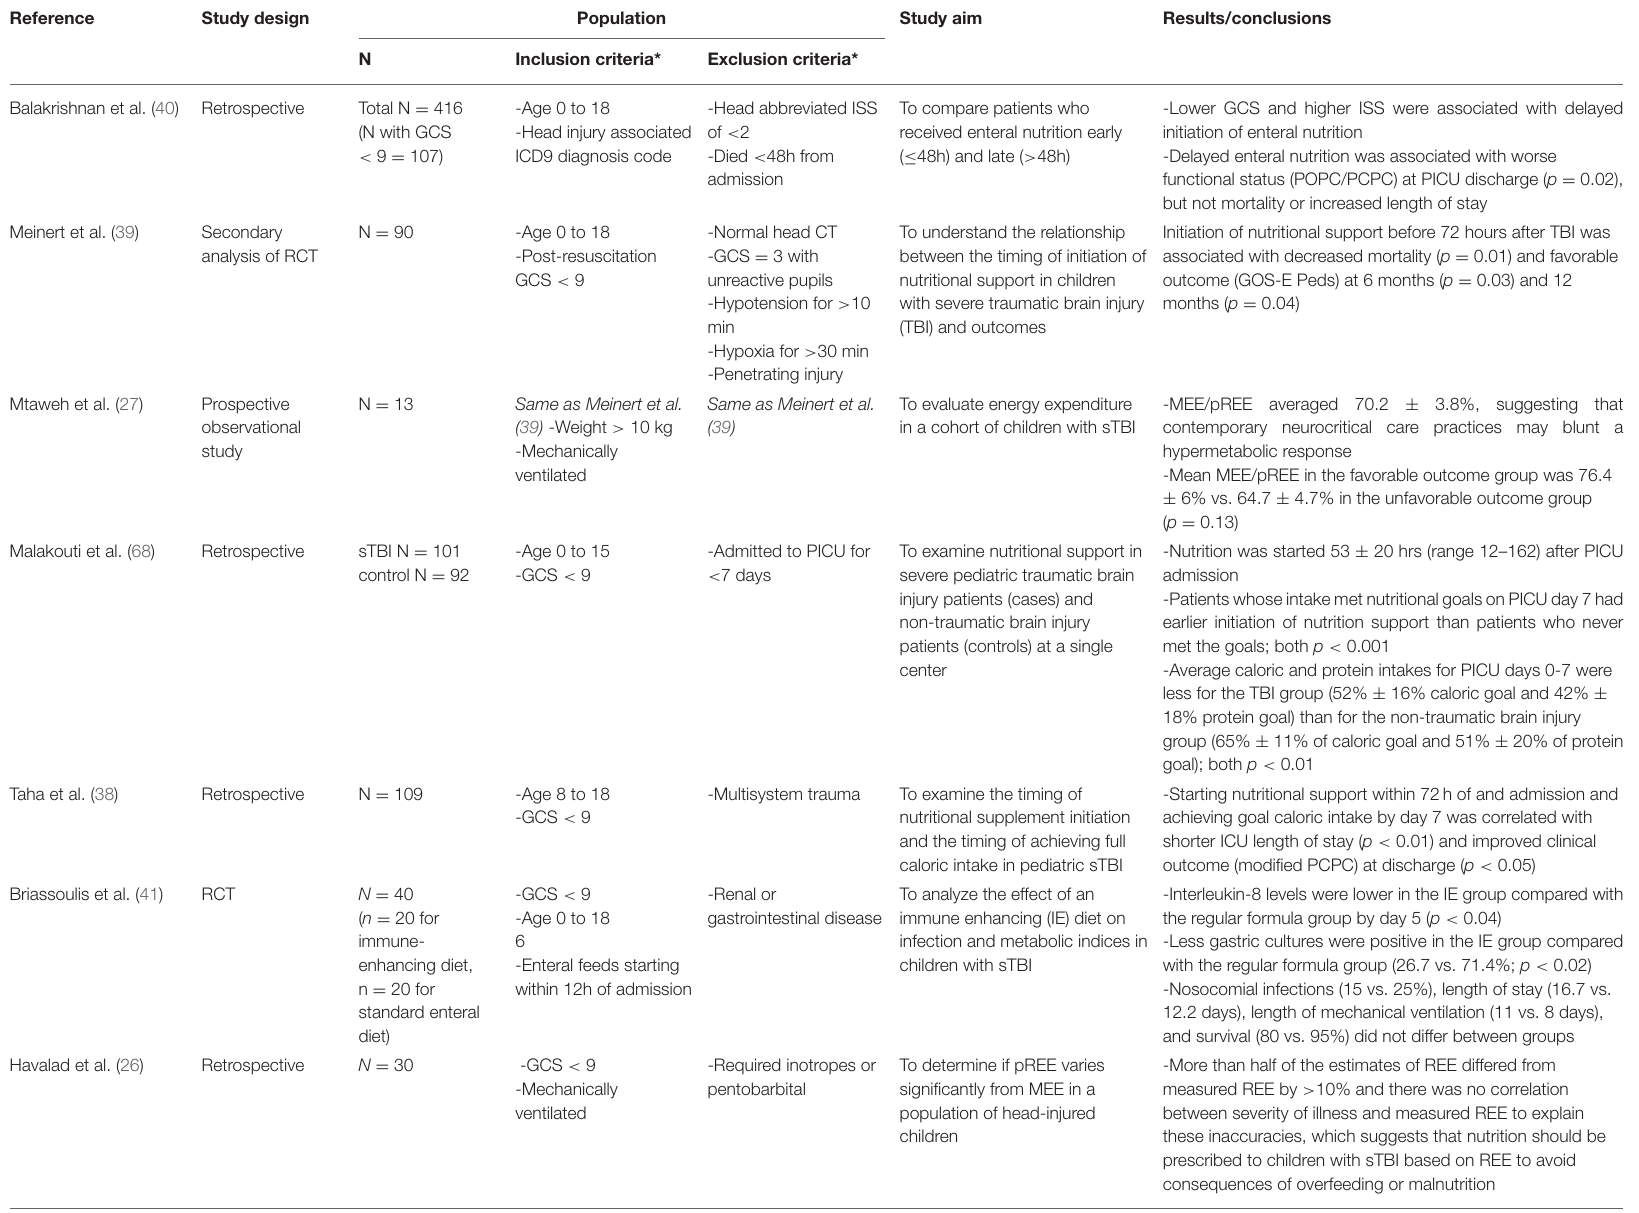
TABLE 1 | Nutrition for pediatric severe traumatic brain